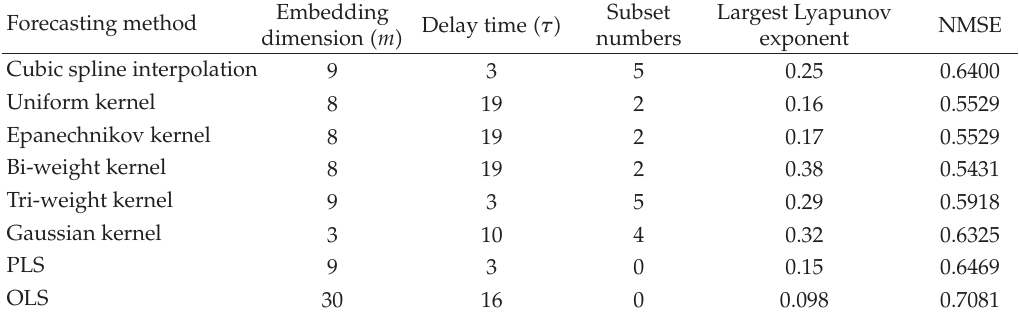
Table 1: Comparative analysis of the optimal results based on various forecasting